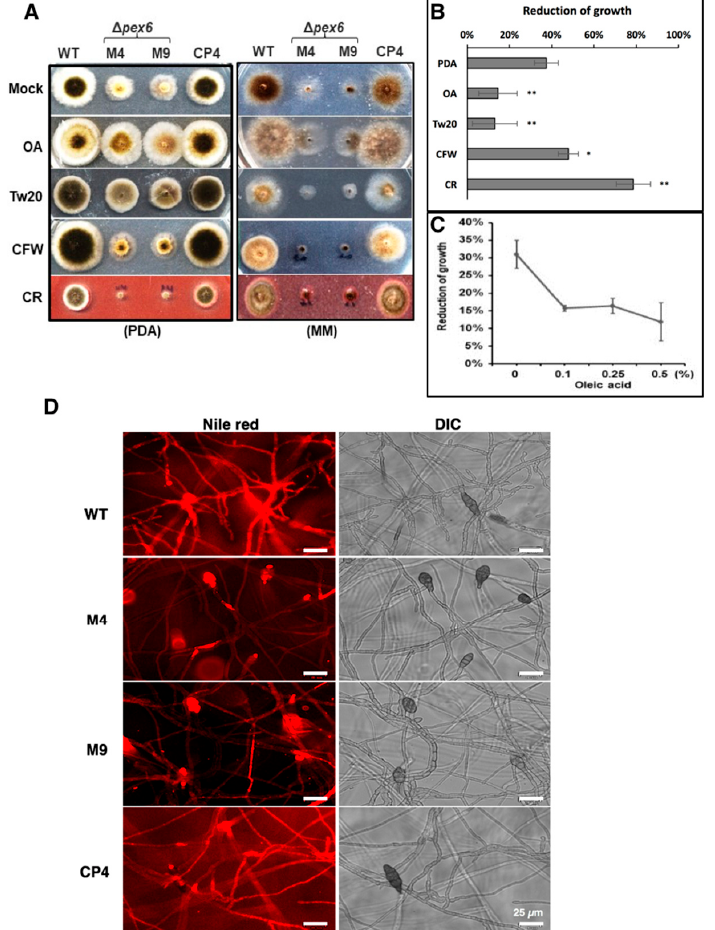
Figure 4. Pex6 is involved in lipid metabolism and maintenance of cell-wall integrity in A. alternata . ( A ) Assays for sensitivity of wild type (WT), two pex6 mutants ( Δ pex6 -M4 and M9) and the complementation strain (CP4) to oleic acid (OA, 0.5%), Tween 20 (Tw20, 0.5%), calcofluor white (CFW, 200 µM) and Congo red (CR, 50 µM) on potato dextrose agar (PDA) or minimal medium (MM); ( B ) Quantitative analysis of chemical sensitivity on PDA. Significance of differences was analyzed using Tukey’s HSD post-hoc test. Means indicated by asterisks are significantly different from wild type, p < 0.01 (**), p <0.05 (*); ( C ) Percentage of growth reduction of Δ pex6 in relation to wild type grown on PDA amended with different concentrations of oleic acid for 3 days; ( D ) Nile red staining of fungal hyphae and conidia for the presence of lipid bodies showing blight red fluorescence.